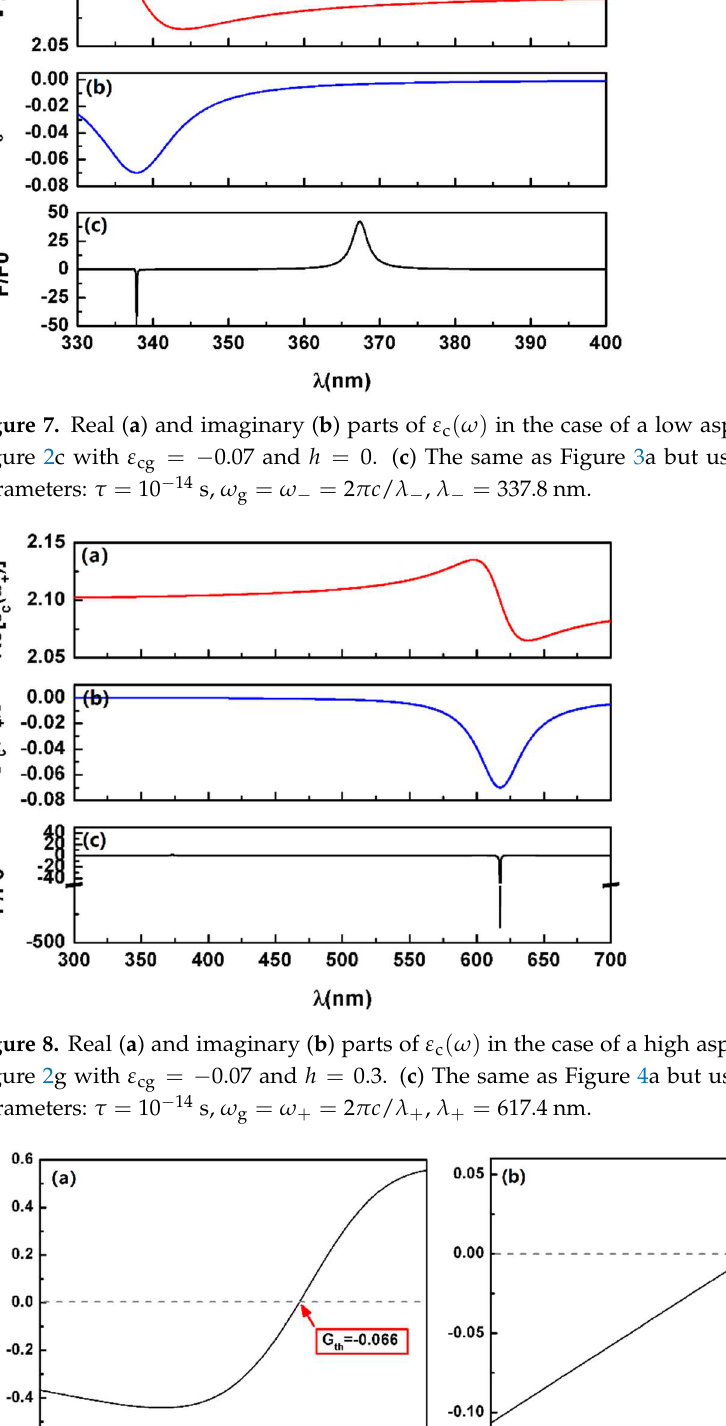
Figure 9. Finding the spaser threshold gain th G for the cases of ( a ) Figure 7 and ( b ) Figure 8.